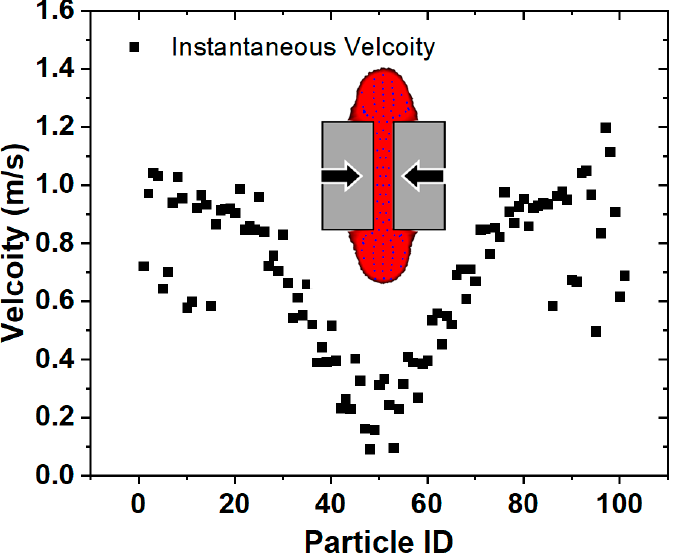
Figure 4. Instantaneous velocities of inclusion particles (upsetting rate: 19.3 m/s).